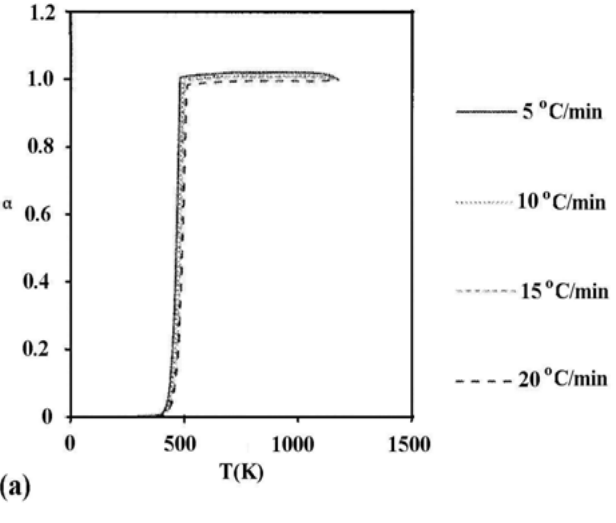
Figure 2. Thermogravimetric data showing the extent of ( a ) un-irradiated and ( b ) γ -irradiated sliver acetate conversion during non-isothermal